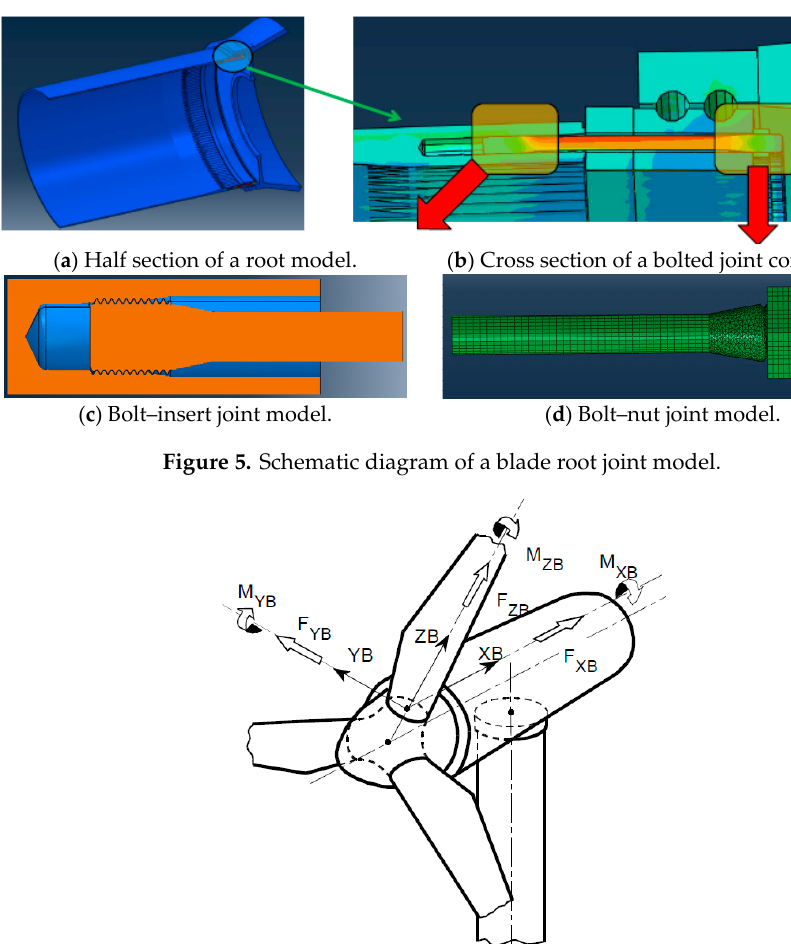
Figure 4. Schematic diagram of a relief cone parameter at the bolt thread.